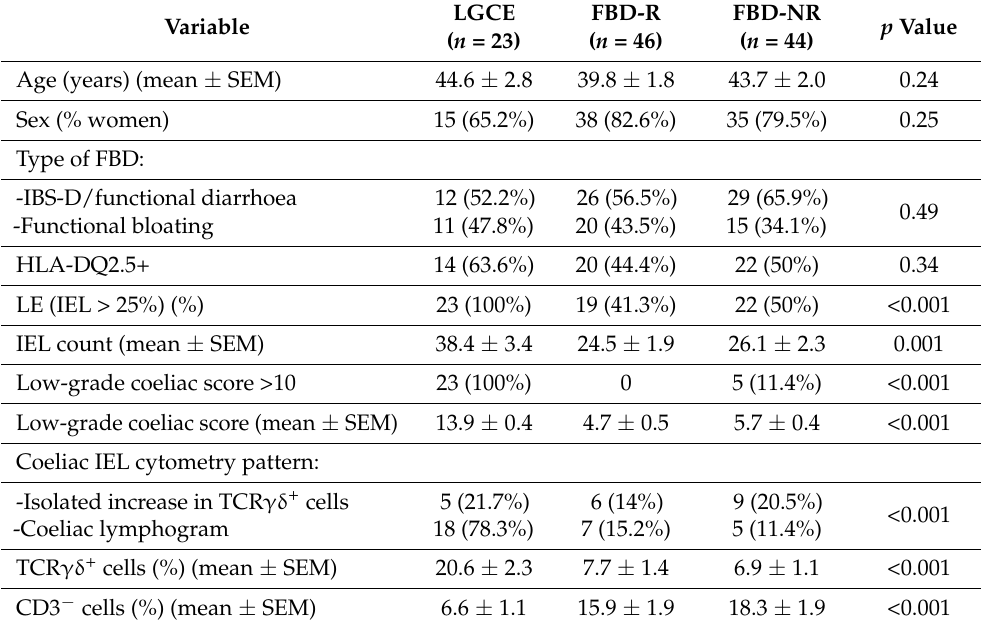
Table 3. Comparison of the study variables among patients with low-grade coeliac enteropathy (LGCE), functional bowel disease GFD responders (FBD-R), and non-responders (FBD-NR)